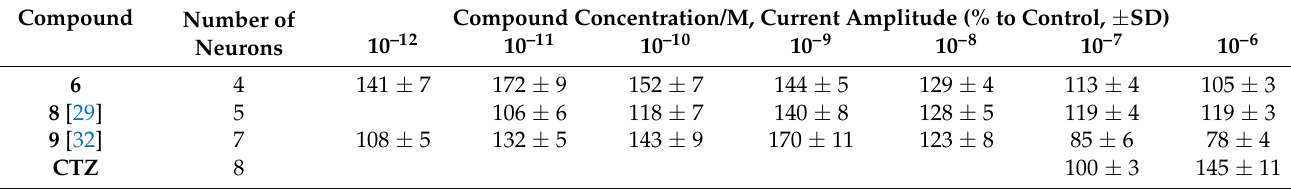
Table 2. The effect of various concentrations of compounds on the kainate-induced AMPA receptor currents in rat cerebellum Purkinje cells.